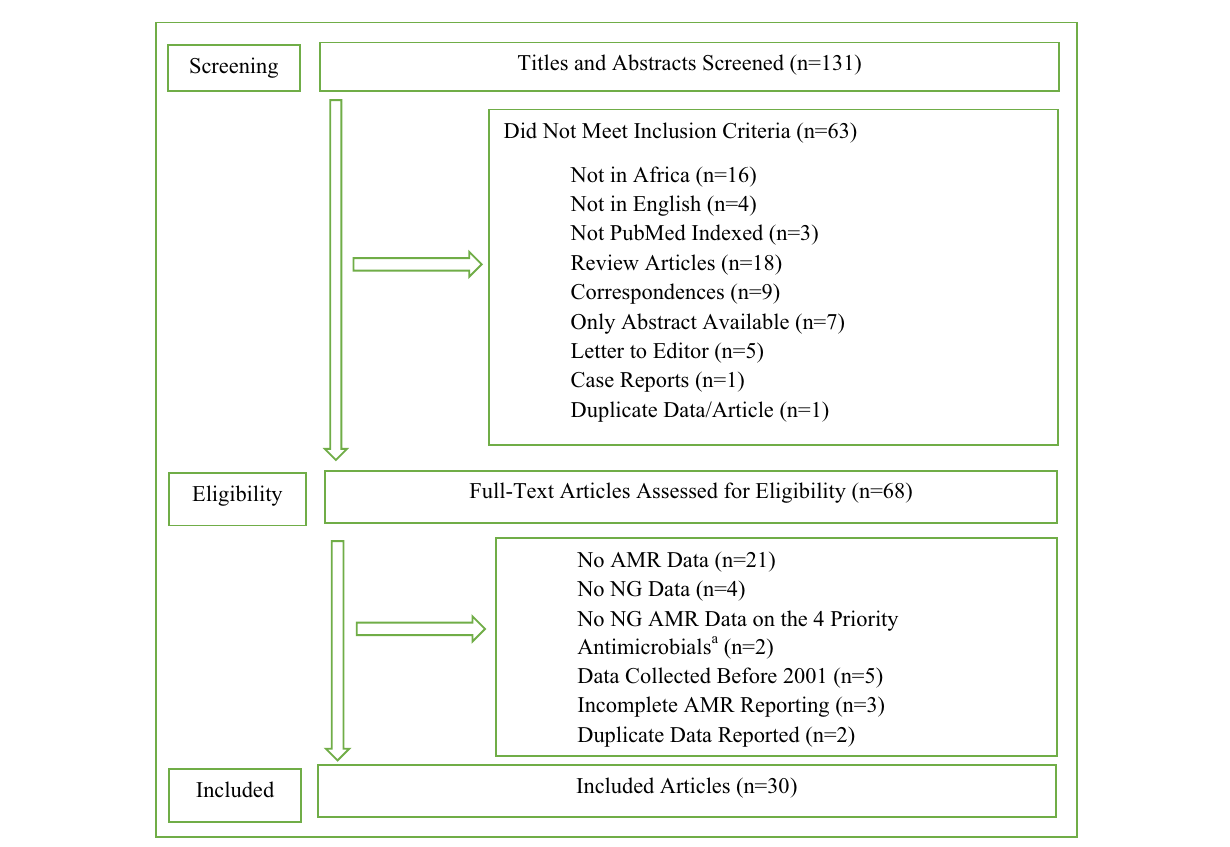
FIGURE 1 Search terms and strategies, and data extraction template. Search History Sorted by Best Match 2001 to 2020. Search String: (Gonorrhea OR Neisseria gonorrhoeae Infection OR Infection, Neisseria gonorrhoeae OR Infections, Neisseria gonorrhoeae OR Neisseria gonorrhoeae Infections OR Gonorrhoea OR Gonococcal Infection OR Gonococcus OR Gonorrhoeae OR Gonorrhoeae growth OR Gonorrhoeae Infection OR Gonorrhoeae Infections OR Gonorrhoeae Strains) AND (Antimicrobial resistance OR Antibiotic resistance OR Antibacterial drug resistance OR Antimicrobial drug resistance OR Antimicrobial drug resistances OR Drug resistance OR Drug resistance, bacterial OR Drug resistance, microbial OR Drug resistances, microbial OR Drug resistance, multiple, bacterial) AND (Africa OR Africa South of the Sahara OR South Africa OR Africa, Western OR Africa, Southern OR Africa, Northern OR Africa, Eastern OR Africa, Central). Results: 131. AMR, antimicrobial resistance; NG, Neisseria gonorrhoeae. a Ceftriaxone, cefixime, azithromycin, and